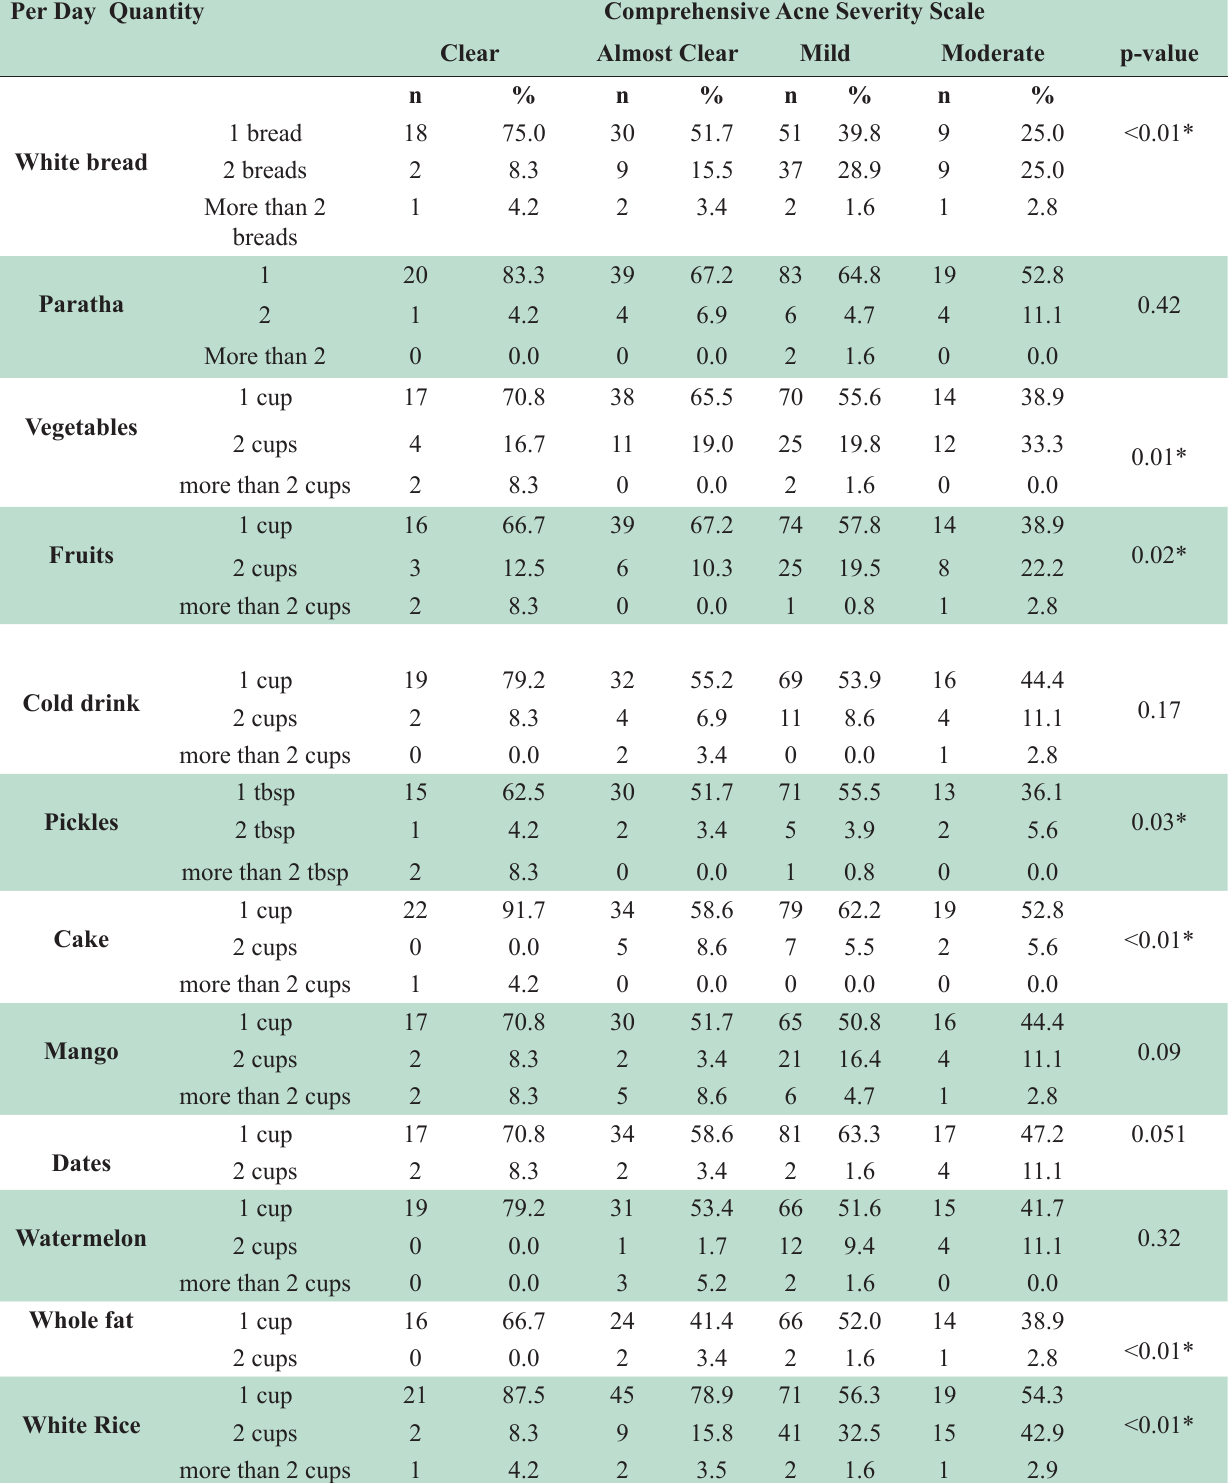
Table-IV: Association of Acne with Dietary